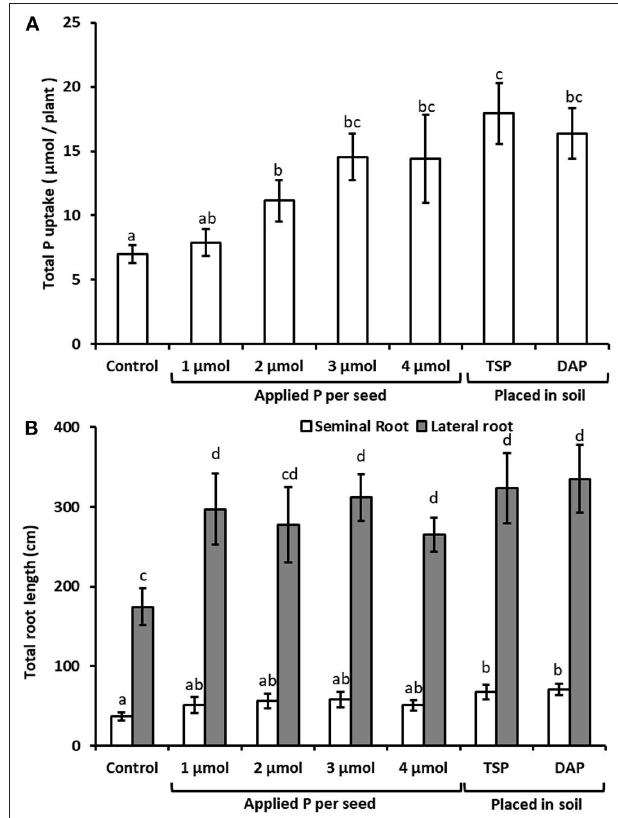
FIGURE 1 | Micro-molar concentration P seed dressings enhance root production and P uptake in Triticum aestivum . Panel (A) shows total length of seminal and lateral roots per plant, after 25 d when using seed P dressings or placed soil P fertilizer compared with an untreated control. Placed fertilizer treatments equated to 885 µ mol P plant − 1 . Panel (B) shows total plant P uptake of the plants reported in Panel (A) , expressed as total P acquired per plant. n = 4 for each treatment except for the 4 µ mol seed dressings where n = 3. Lower case letters indicate values that differ significantly at the p < 0.05 level (one-way ANOVA). Error bars are standard errors of the mean (SEM). The seed treatment was potassium phosphate, the soil treatments were granules of TSP (triple super phosphate) and DAP (diammonium